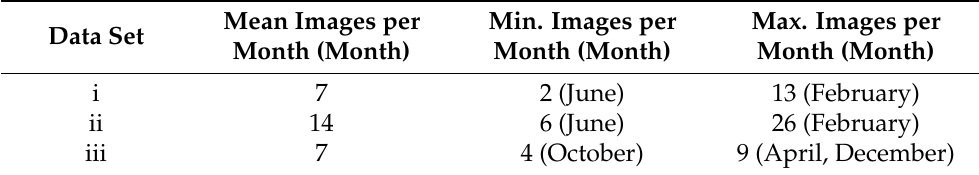
Table 5. Available data sets to build climatology: (i) tM1c (2000–2009), 76 images; (ii) tM4c or tM6 (2000–2020), 168 images y; (iii) tM2c, tM3c or tM5c (2013–2020), 85 images. Number of images per month: mean, minimum (Min.) and maximum (Max.) values.